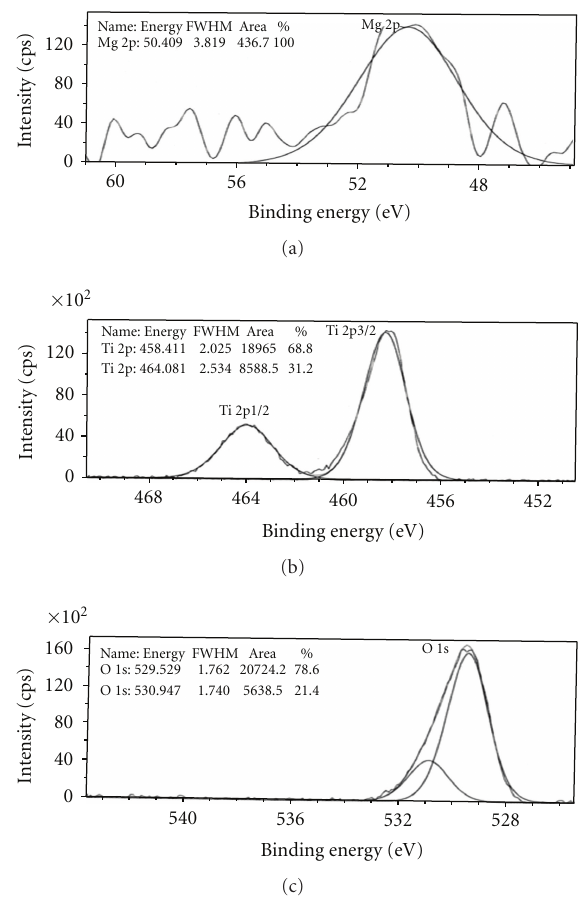
Figure 6: (a) High resolution of Mg 2p spectrum, (b) high resol- ution of Ti 2p spectrum, and (c) high resolution of O 1s